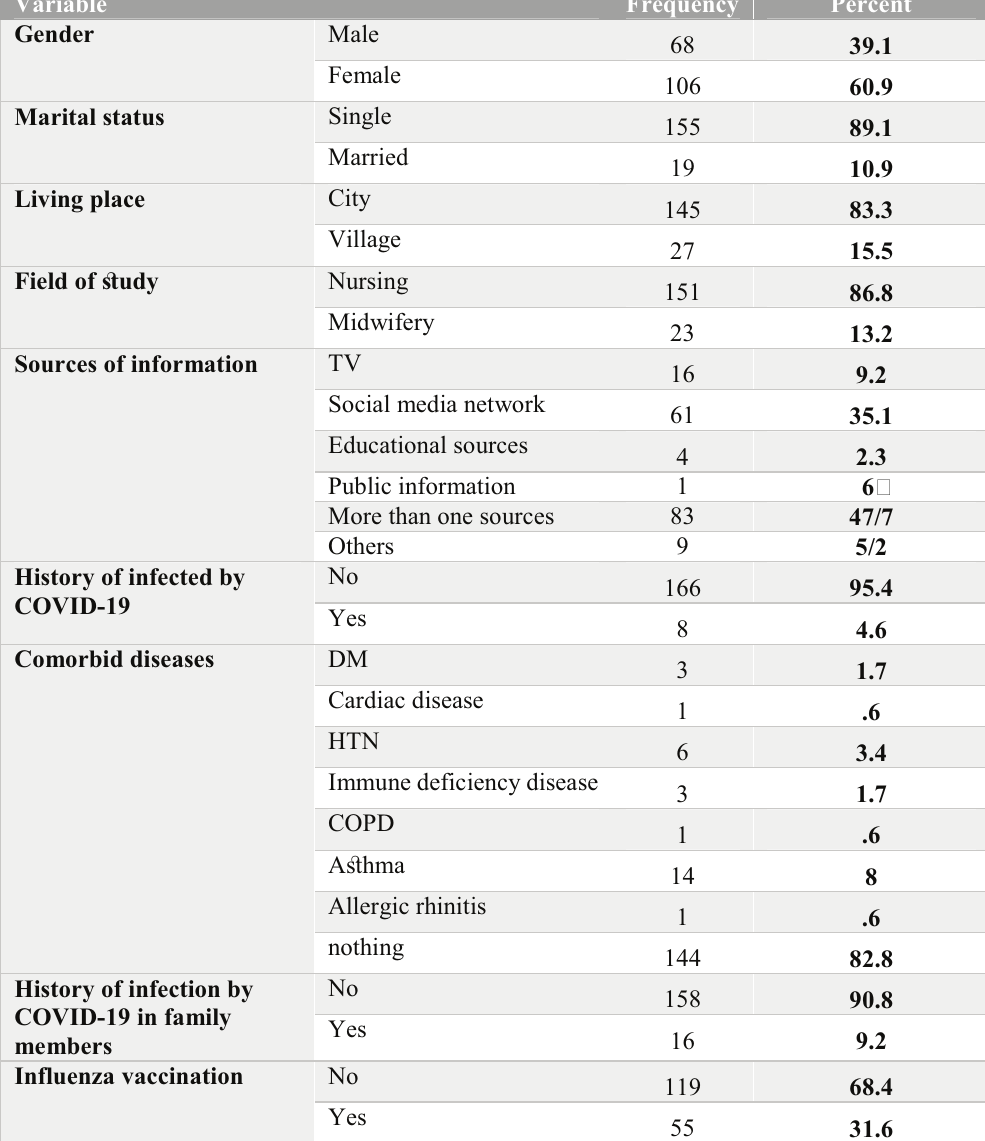
Table 1: Frequency distribution of demographic and clinical characteristics of